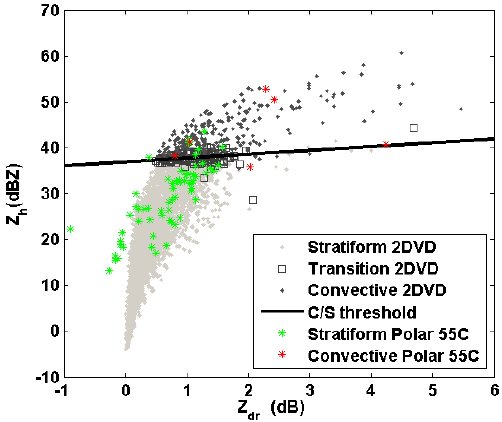
Figure 10. Plot of the Z h and Z dr obtained from the disdrometer measured RSD through electromagnetic simulation for all the data sets collected by 2-DVD (gray markers). The different gray shades are based on the C/S classification of Bringi et al. (2009). The C/S threshold is shown by Eq. (3). The rainy minutes above the C/S threshold are classified as convective, and the ones below as strat- iform. Colored stars denote the Polar 55C measurements collected over the Sapienza site (elevation 1.6 ◦ ) for all the databases classified according to Baldini and Gorgucci